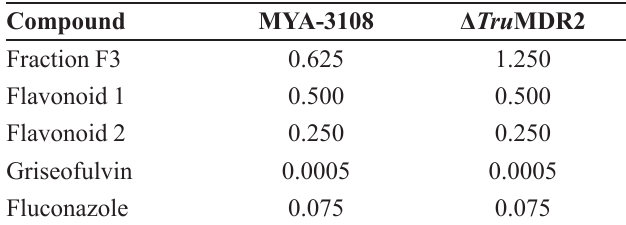
TABLE I - Minimum inhibitory concentration (mg/mL) of fraction F3 and flavonoids isolated from Anemopaegma arvense against Trichophyton rubrum strains (MYA-3108 and ΔTru MDR2)